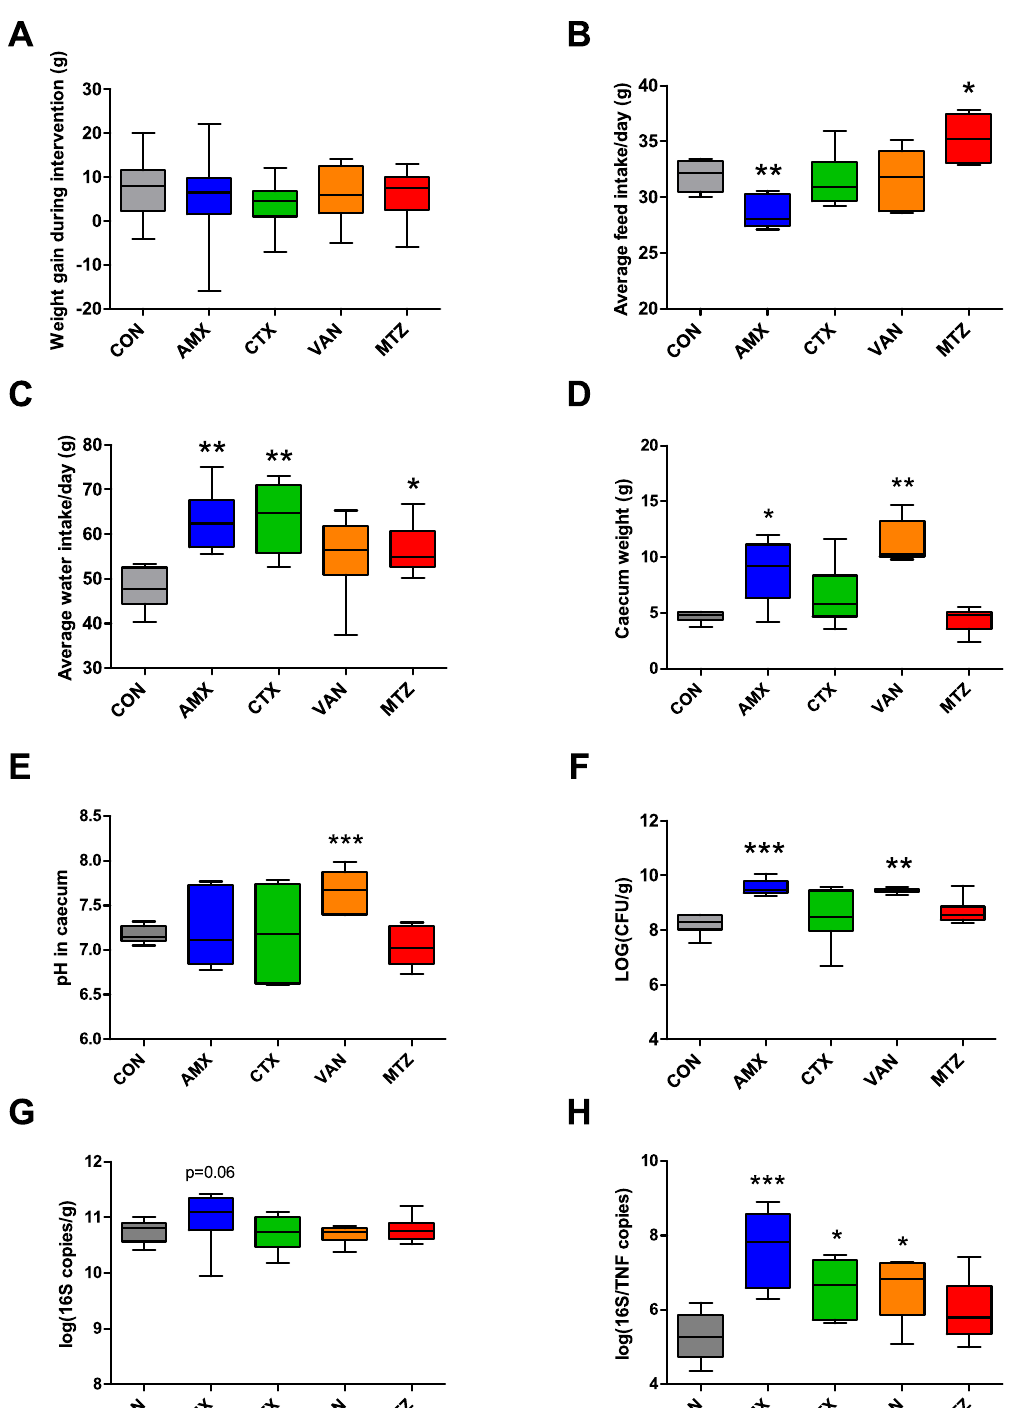
Fig 1. Effects of antibiotics on anthropometric measures and bacterial load. (A) Weight gain during the intervention with antibiotics (Day 0 to 9). (B) Average feed intake per day during the intervention period. (C) Average water intake per day during the intervention period. (D) Weight of caecum and (E) pH in caecum content. (F) Total anaerobic bacterial load in faecal samples determined by culturing on Wilkins-Chalgren agar. (G) Total number of 16S rRNA gene copies/g faecal sample determined by qPCR and (H) 16S rRNA gene to TNF gene ratio in faecal samples determined by qPCR. In all panels boxplots with whisker denoting the full range are shown. Significant differences between treatment groups and the control group are indicated by asterisks ( * P < 0.05, ** P < 0.01, *** P < 0.001). CON, control; AMX, amoxicillin; CTX, cefotaxime; VAN, vancomycin; MTZ, Metronidazole.